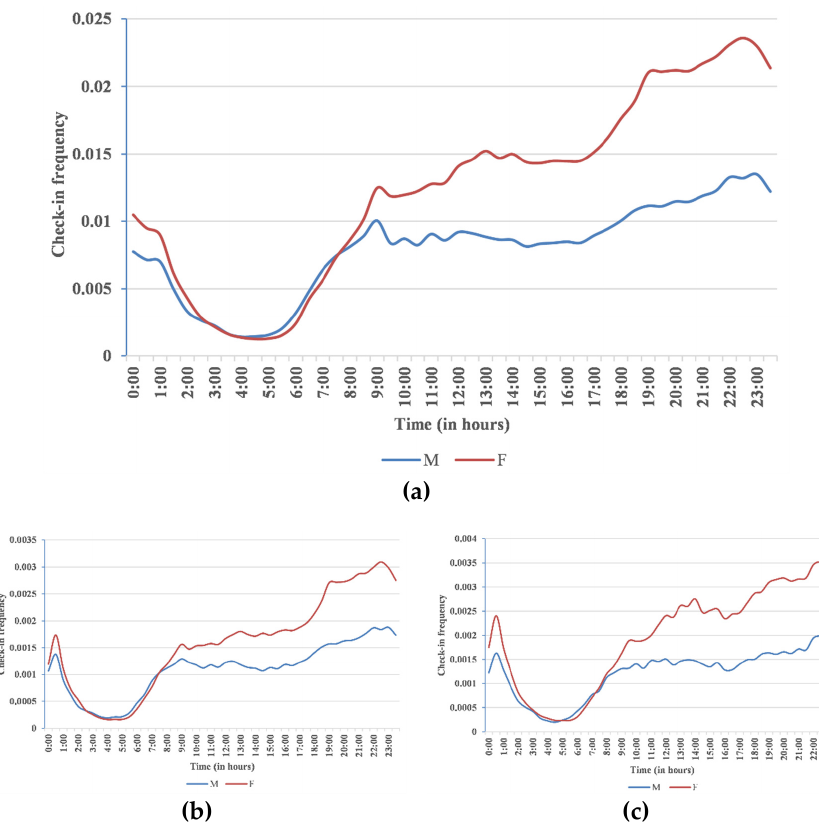
Figure 8. Check-in frequency of male and female during ( a ) a day, ( b ) a weekday, and ( c ) a weekend.